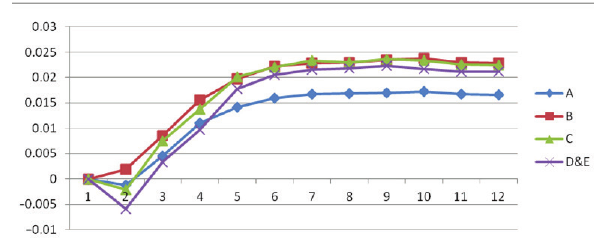
Figure 9e. Accumulated impulse response of PRI to shocks in the number of households